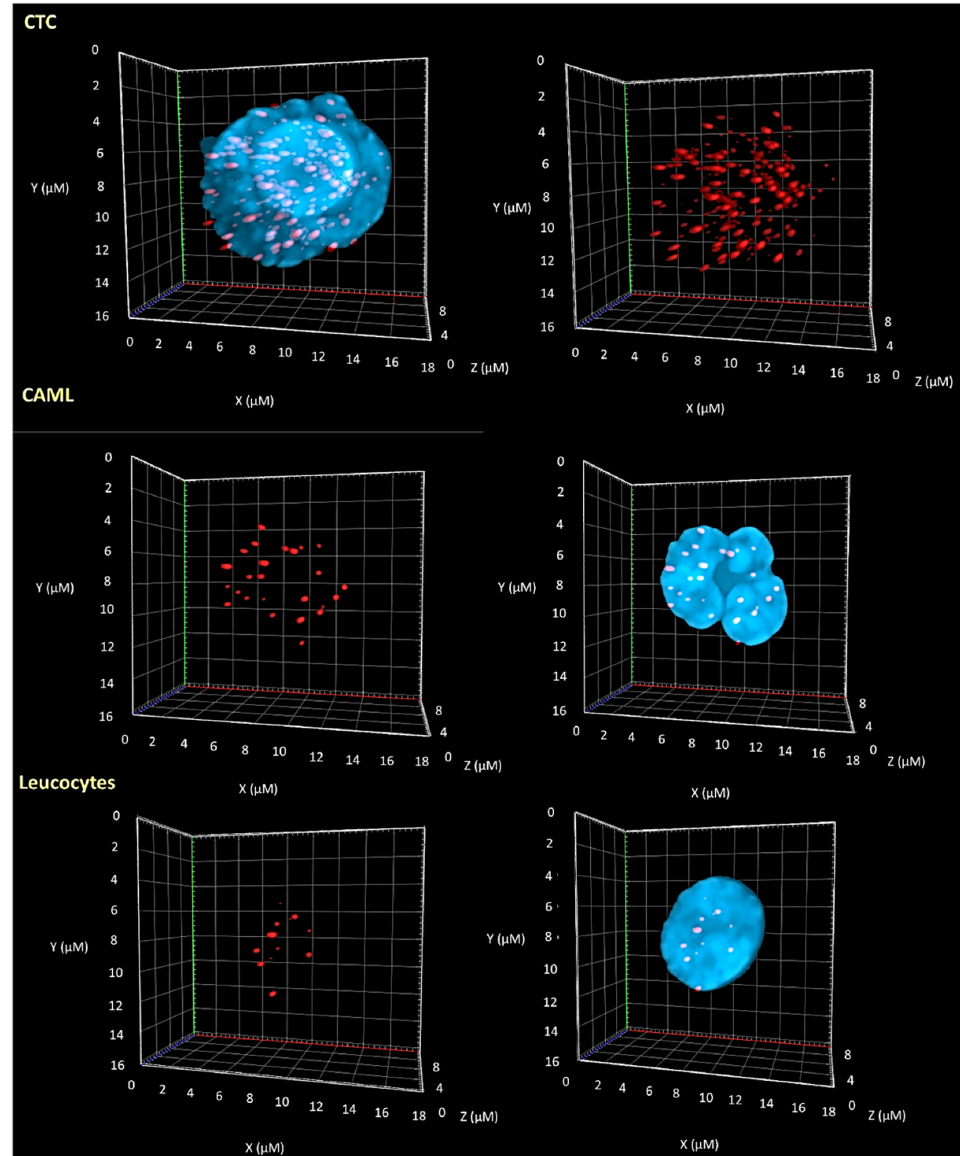
Figure 3. Differences in the 3D nuclear telomeric architecture between CTCs, CAMLs, and leucocytes. Representative nuclei, counterstained with DAPI (blue) from melanoma patient samples (patient 2). The Cy-3 labeled telomeres appear as red signals.